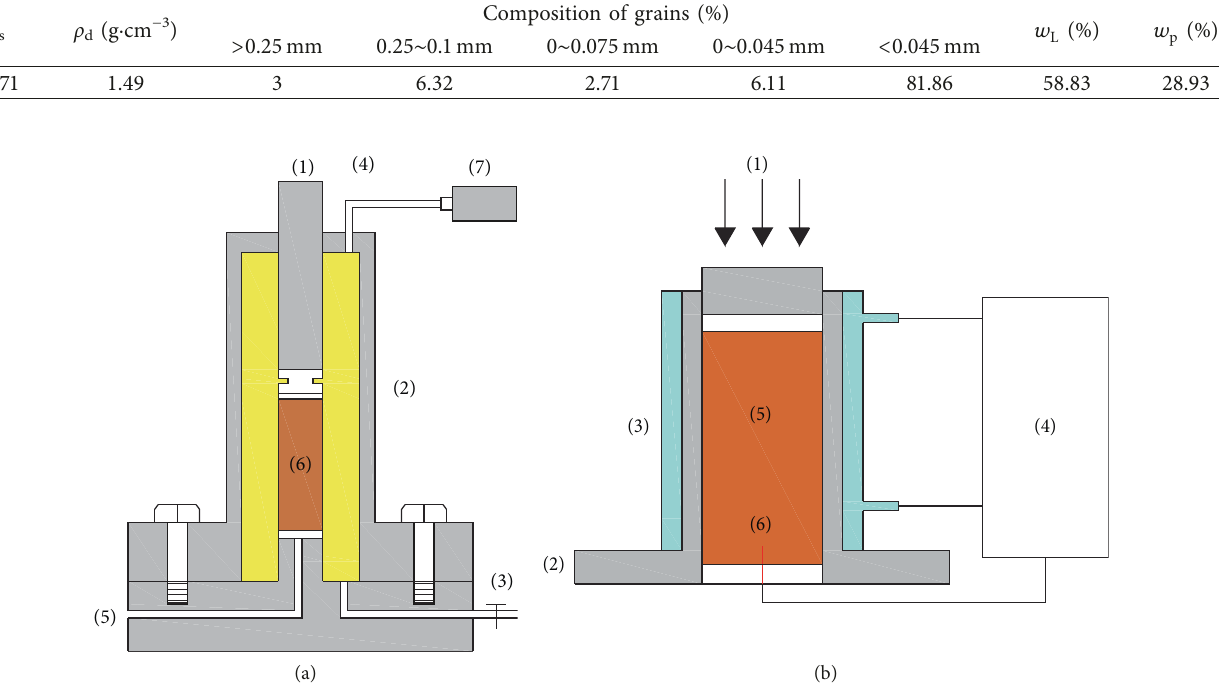
Figure 1: High-pressure consolidation and loading-freezing equipment. (a) SKA-1 K 0 consolidation instrument. (1) Axial loading bar; (2) pressure cell; (3) oil inlet; (4) oil outlet; (5) drainage channel; (6) specimen; (7) hydraulic sensor. (b) Loading-freezing system.